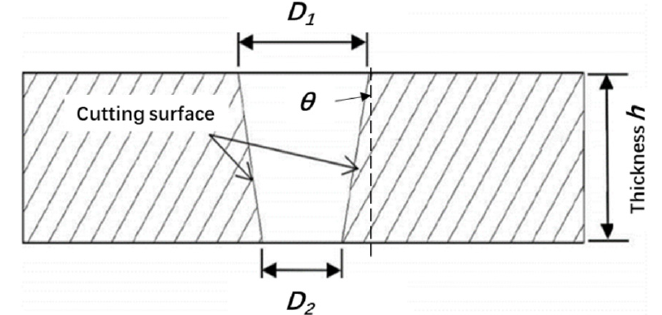
Figure 3. Hole taper during CFRP laser cutting.